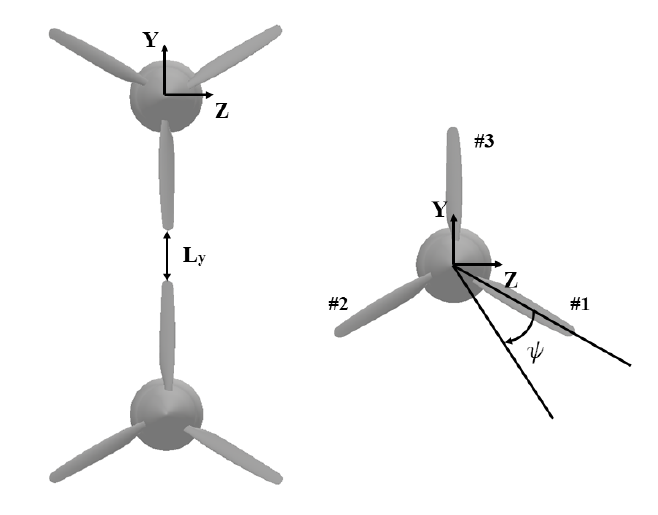
Figure 6. Sketch of the side-by-side propeller configuration including the reference system ( left ) and the blade azimuthal angle definition ( right